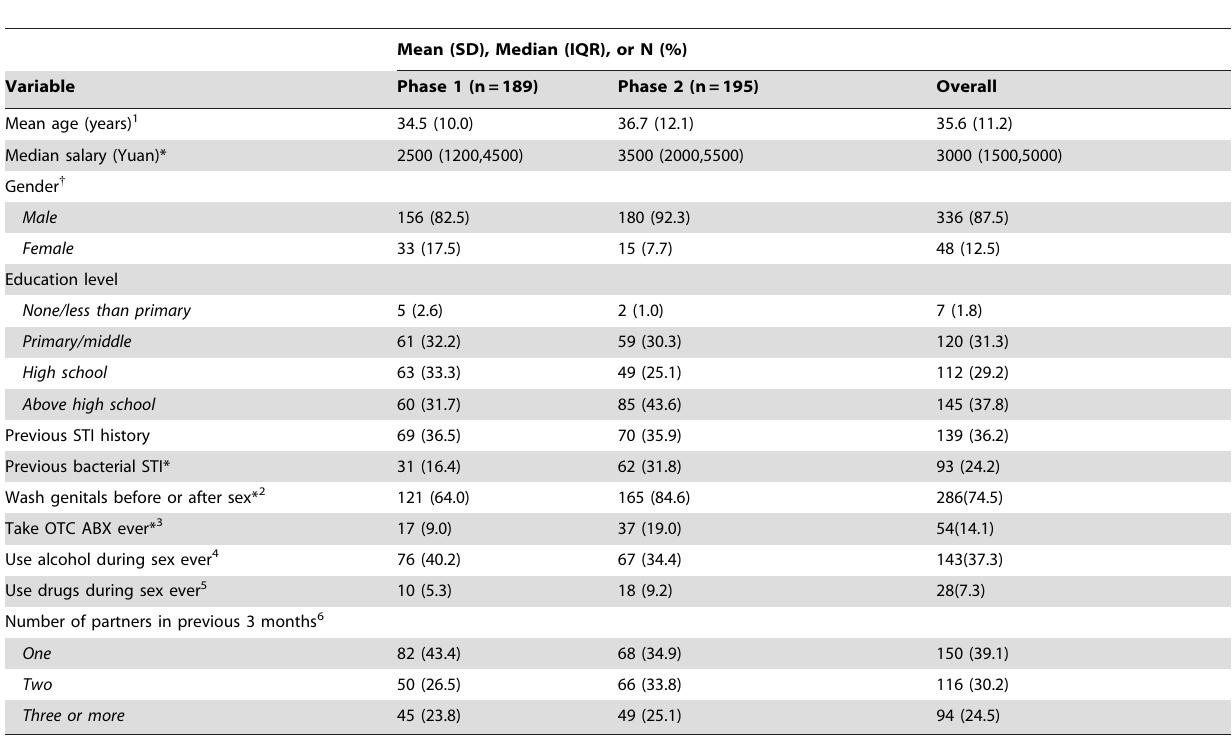
Table 1. Selected demographic characteristics and risk behaviors of a sample of clients from the Shanghai Sexually Transmitted Infection and Skin Disease Hospital